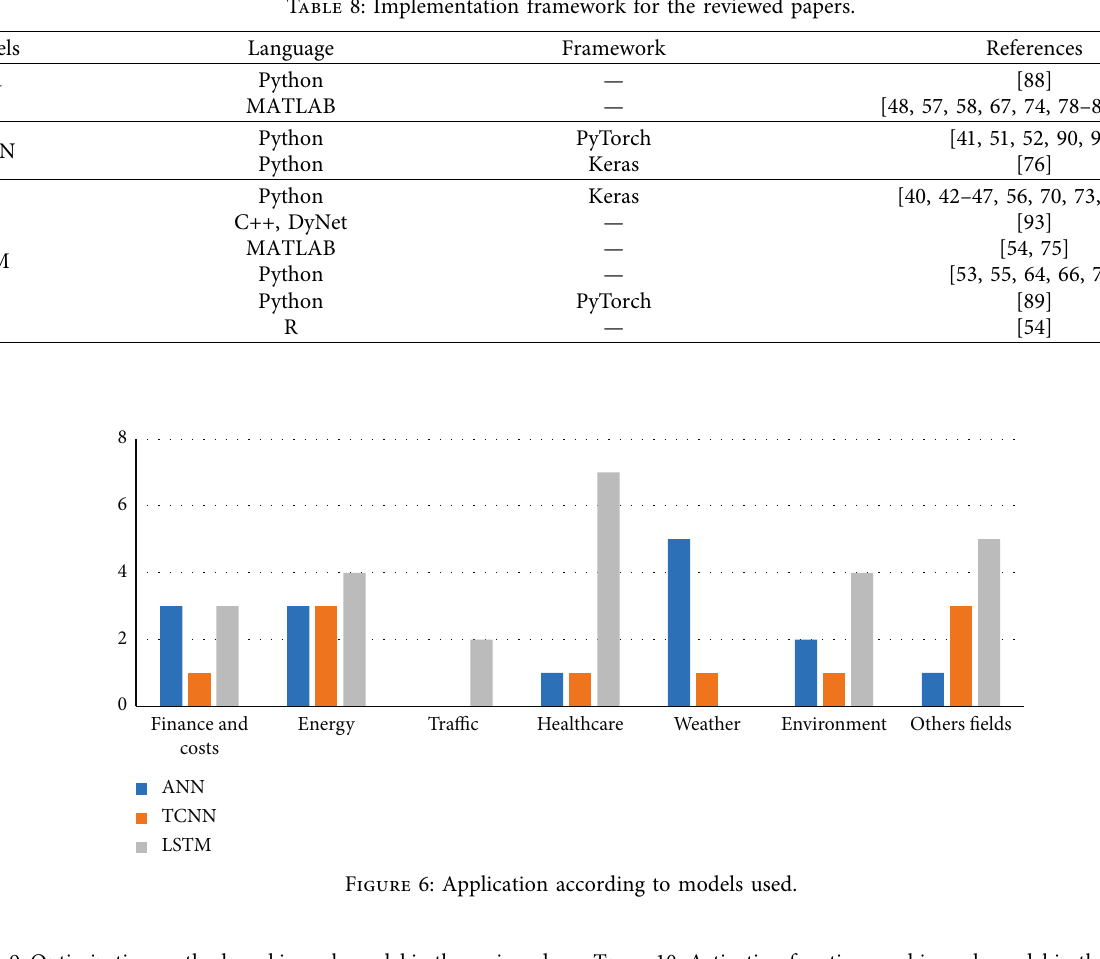
Table 9: Optimization method used in each model in the reviewed articles.